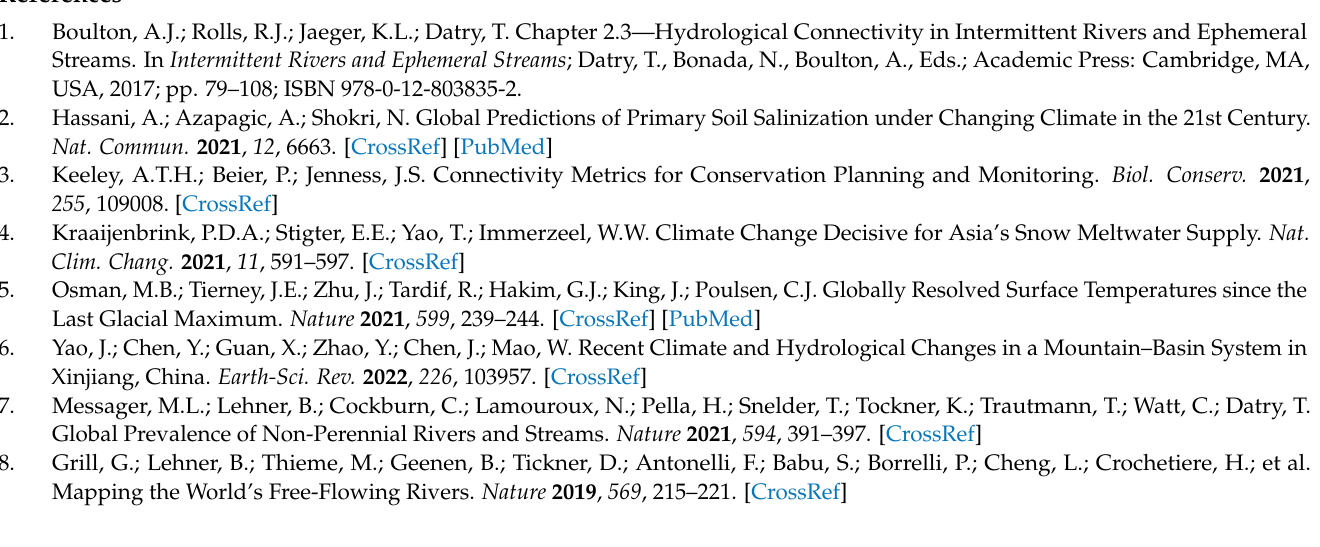
Figure S3. Arable land area and population change of BLB, Figure S4. Temporal and spatial variations of PREC, ETa and TMP and their significance tests. Black dots represent passing the p < 0.05 test, Figure S5. Variation of IIC at different distance thresholds, Figure S6. 1990–2019 BLB (a) variations of TWA, PWA, SWA, (b) percentage of PWA and SWA, and (c) conversion between different types of water bodies, Figure S7. (a) Water area distribution in 1990, (b) water area distribution in 2019, (c) water area change from 1990 to 1996, (d) water area change from 1996 to 2000, (e) water area change from 2000 to 2005, (f) water area change from 2005 to 2010, (g) water area change from 2010 to 2015, (h) water area change from 2015 to 2019, Table S1. Details of the data source for this article, Table S2. Classification results of wet, dry and normal years from 1990 to 2019, Table S3. Chinese Environmental Quality for Surface Water III Standard(GB3838-2002), Table S4. Standard for classification of fresh and salt water, Table S5. Characteristic values of interannual variation of water quality indexes, Table S6. Multiple stepwise regression results, Table S7. Water System connectivity Project of BLB. References [82–85] are cited in Supplementary